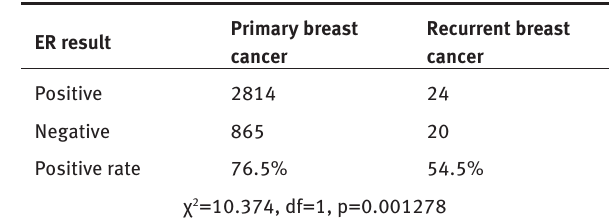
Table 2: Difference in ER expression between primary and recurrent breast